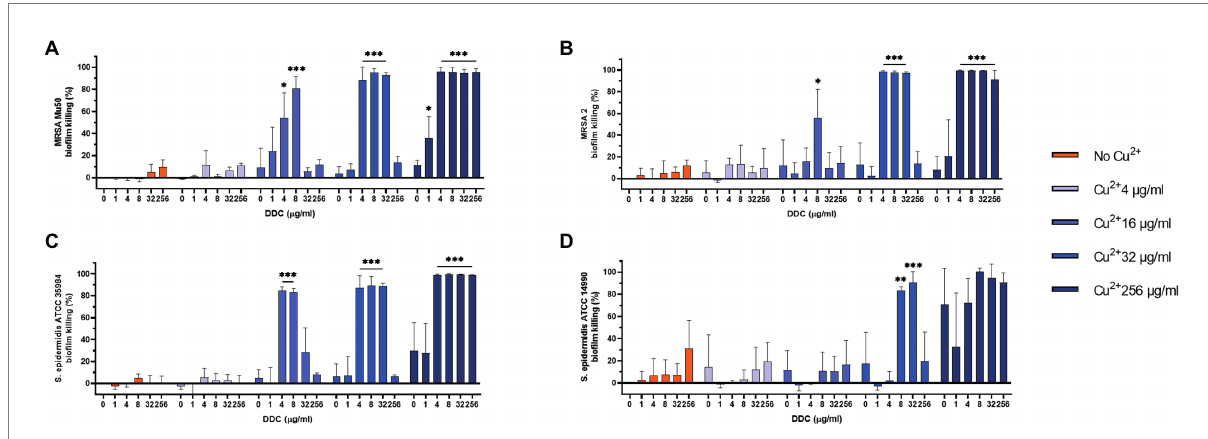
FIGURE 1 Effect of diethyldithiocarbamate (DDC) and Cu 2+ concentrations (in μ g/ml) on the viability of (A) MRSA Mu50, (B) MRSA 2, (C) Staphylococcus epidermidis ATCC 35984 and (D) S. epidermidis ATCC 14990 biofilms compared to monotherapy with Cu 2+ ( n = 3; * p < 0.05; ** p < 0.01; *** p < 0.001).